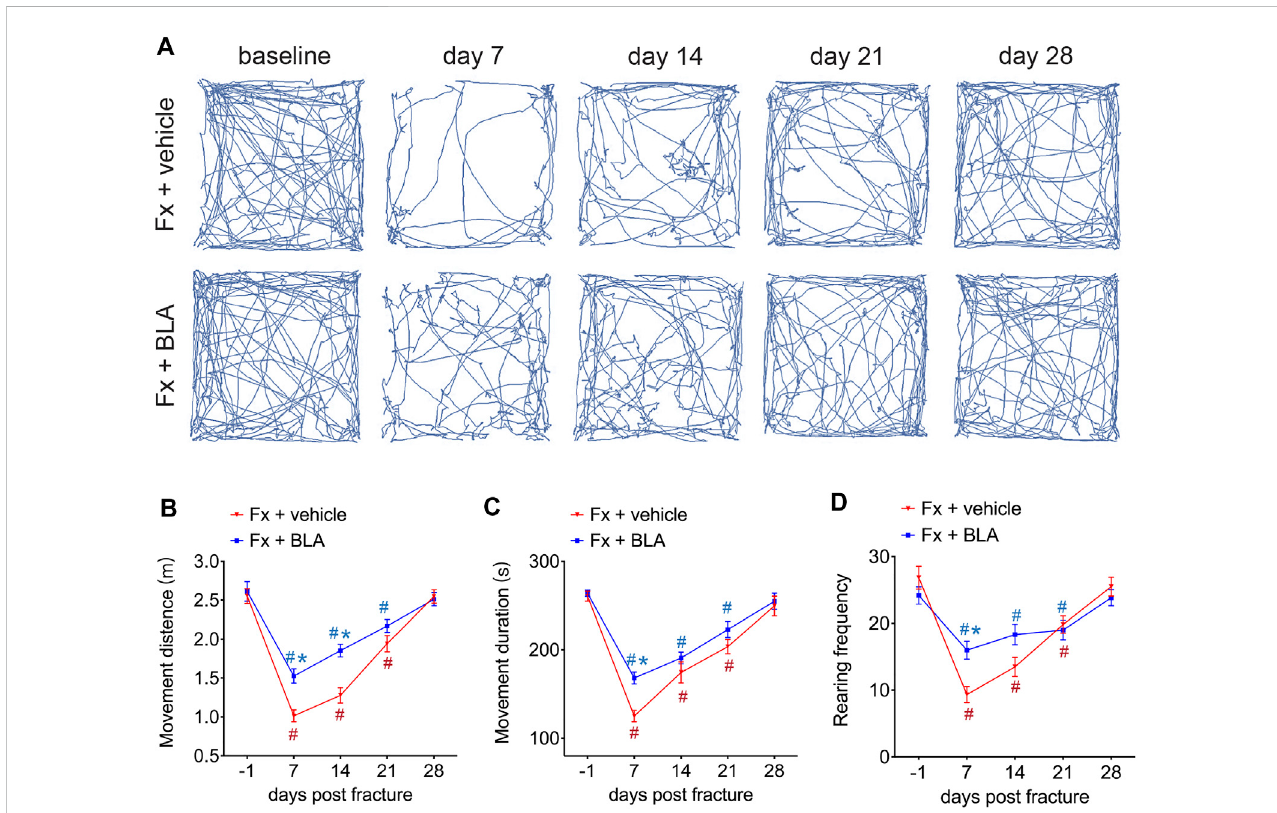
FIGURE 2 TheEffectsofBLAonnociceptivebehaviors. (A) RepresentativemovementtracesatserialtimepointsafterfractureinmicetreatedwithBLAorvehiclein the open fi eld test. Fx, fracture. (B) Quantitative analysis of movement distance of the two groups. N = 6 per group. (C) Quantitative analysis of movement durationofthetwogroups. N =6pergroup. (D) Quantitativeanalysisofrearingfrequencyofthetwogroups. N =6pergroup.Valuesareexpressedasmean± SEM. Two-way repeated-measures ANOVA, Dunnett ’ s multiple-comparisons test for differences within each group: # p < 0.05 when compared with baseline (day-1); Bonferroni ’ s multiple-comparisons test for differences between groups: * p < 0.05 when compared with vehicle